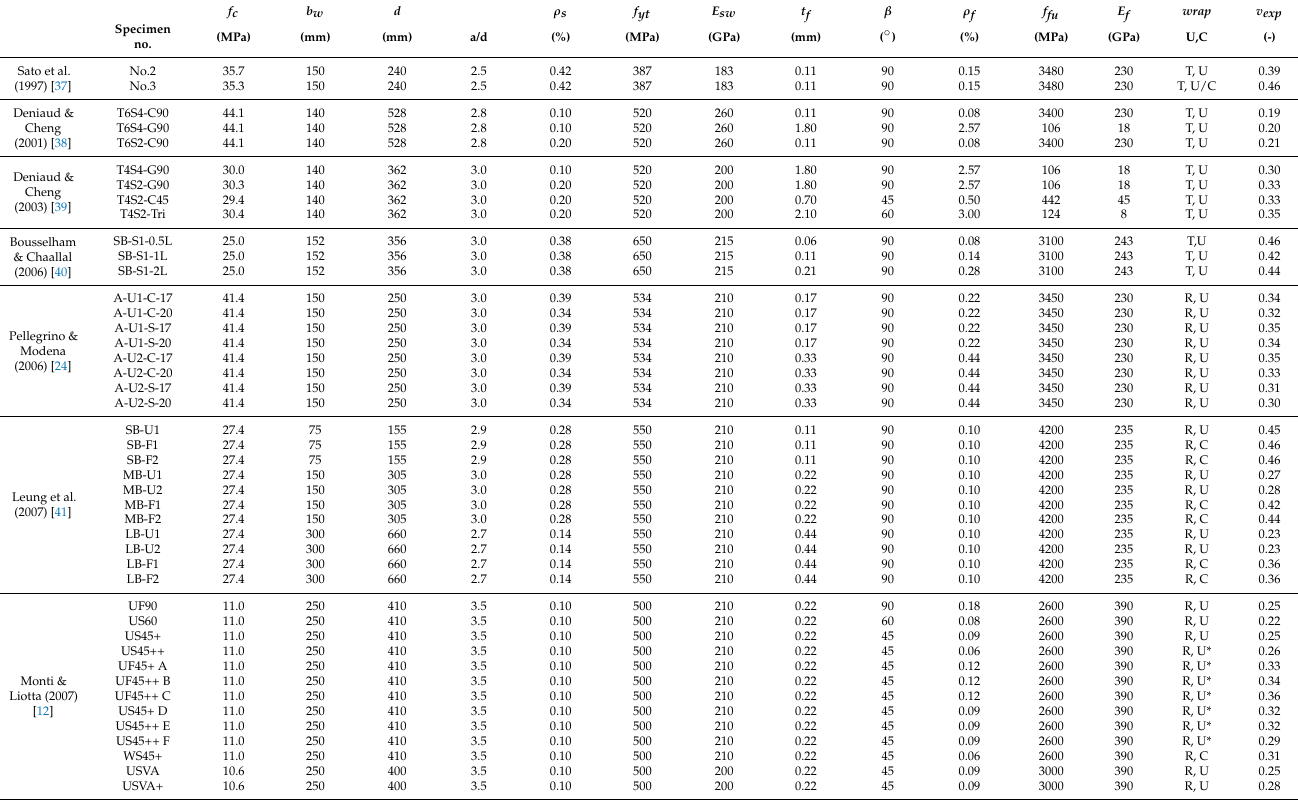
Table A1. Details of specimens along with the results obtained after experimental